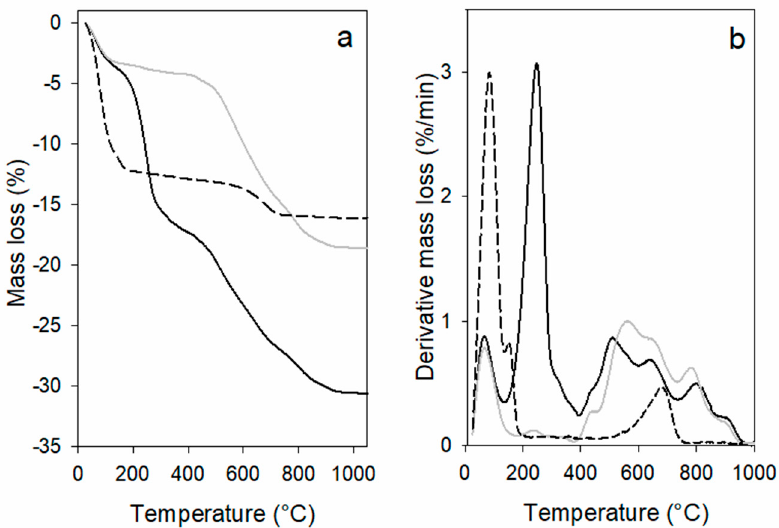
Figure 6. Thermal analyses of Mt (black dashed lines), Mt-CuPhen (solid gray line) and Mt-CuPhen-exp H 2 S-25d (black solid lines). ( a ) Thermogravimetric analysis tracings (TGA), ( b ) corresponding derivative signals of thermogravimetric curves (DTGA).